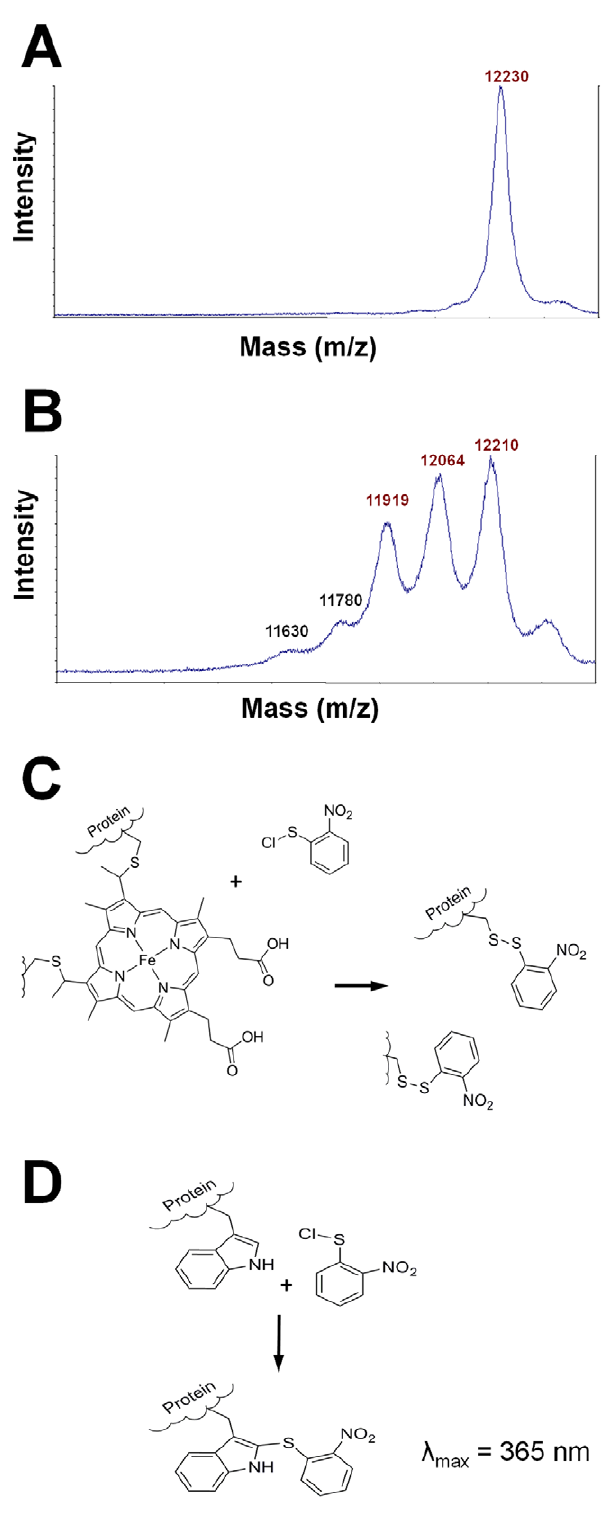
Figure 2. Mass determination and heme cleavage of cyto- chrome c -554 from Methylosinus trichosporium OB3b. A. Mass spectrum of the native cytochrome c -554 from Methylosinus trichos- porium OB3b. B. Mass spectrum of cytochrome c -554 after treatment with 2-NPS. The number of peaks is due to protein adducts with different number of added 2-NPS molecules. C. The reaction of 2-NPS with the covalent heme attachment, resulting in a disulphide